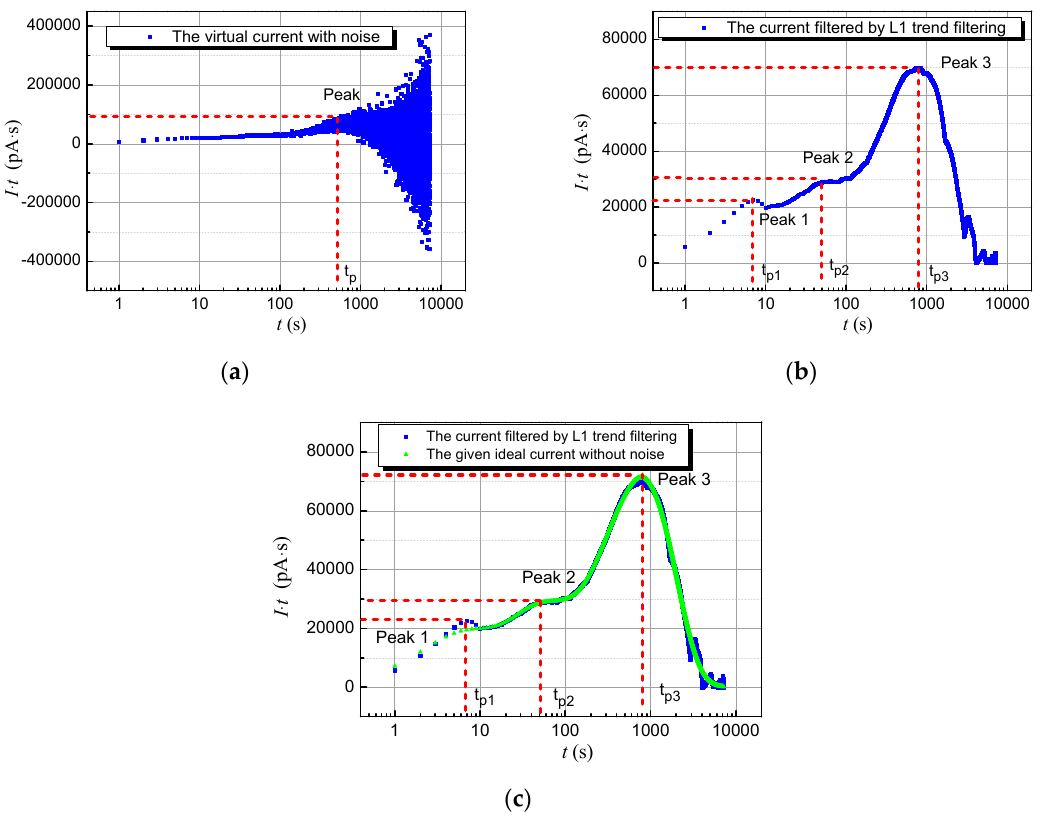
Figure 9. The diagram the product of the polarization absorption current with time (I × t) with log10 t : ( a ) The polarization absorption current with noise; ( b ) the polarization absorption current filtered by L1 trend filtering; and ( c ) the comparison of polarization absorption current filtered by L1 trend filtering and the given ideal trend time.